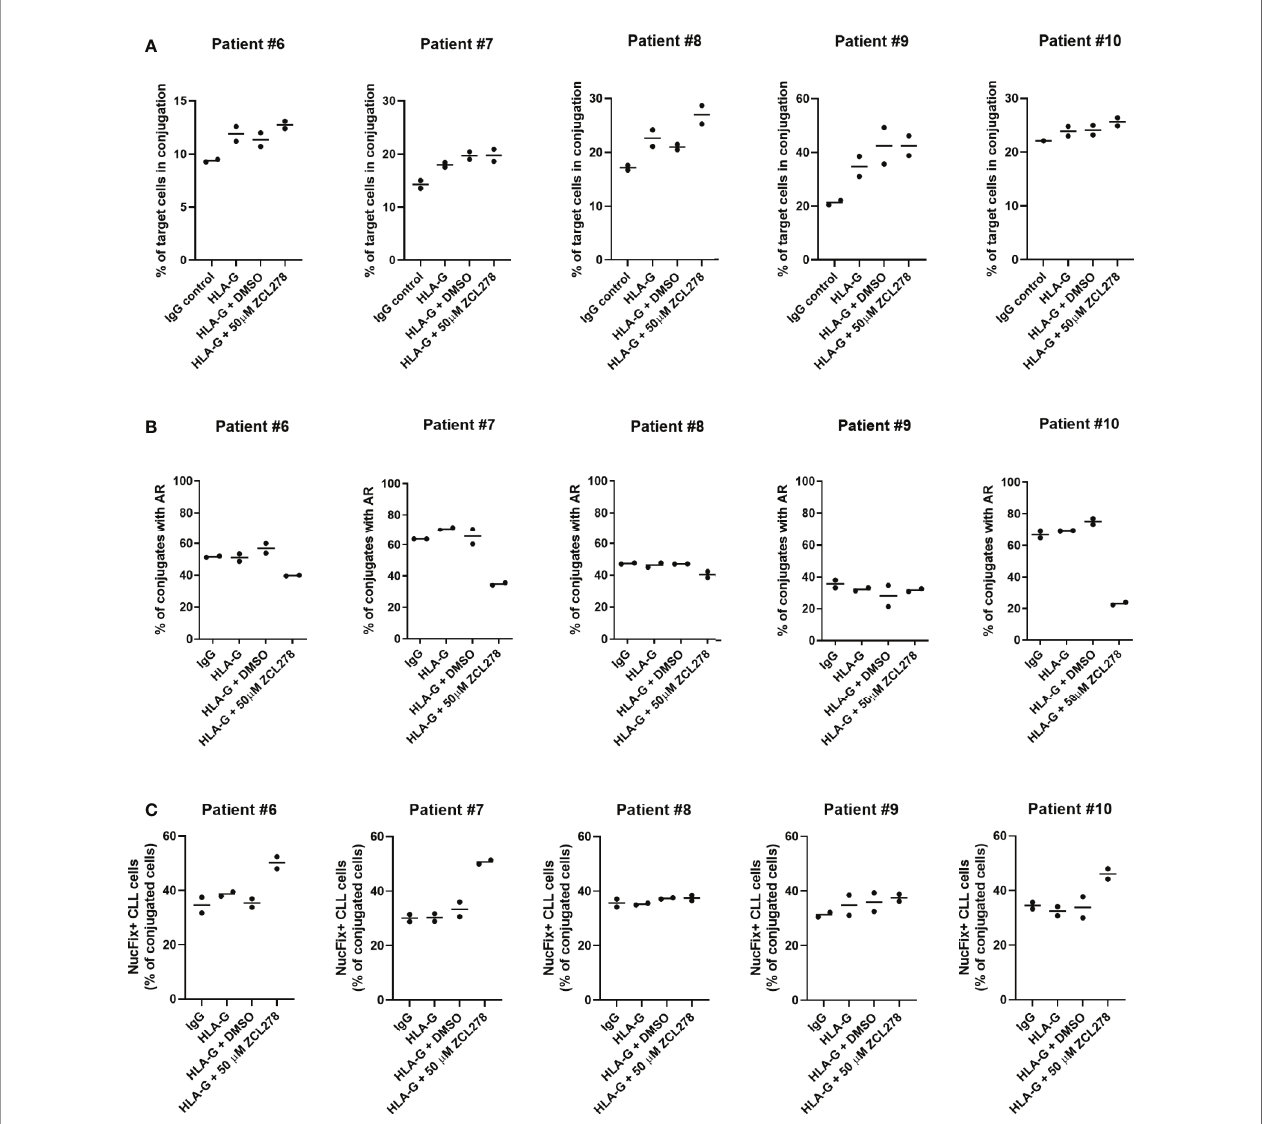
FIGURE 6 | Inhibition of the actin response in combination with anti-HLA-G blocking antibody substantially improves NK cell-mediated killing of CLL cells. (A) Conjugation frequency of primary CLL cells as quanti fi ed by imaging fl ow cytometry in the absence or presence of HLA-G blocking antibody. Target cells were incubated with 10 µg/mL control IgG or blocking antibody against HLA-G, and were used either untreated (IgG, HLA-G), DMSO treated, or after incubation with 50 µM ZCL278 for 1 h before conjugation. Effector and target cells were co-cultured at a 3:1 E:T ratio for 45 min at 37°C and fi xed with 2 v/v% PFA. Target cells in conjugation are shown as % of total target cells. (B) Quantitative analysis of primary CLL-NK cell conjugates with an actin response in the presence of control IgG or anti-HLA-G blocking antibody by imaging fl ow cytometry. Target cell were either untreated (IgG, HLA-G) or conjugated after treatment with vehicle (DMSO) or 50 µM ZCL278. For each patient, a minimum of 100 conjugates were analyzed. (C) Average percentage of Live-or-Dye NucFix ™ Red positive primary CLL cells in conjugation with NK-92MI cells in the presence of control IgG or anti-HLA-G blocking antibody. Target cells are either untreated, treated with vehicle control or 50 µM